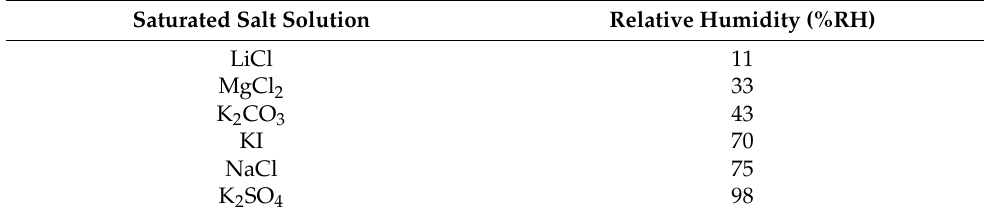
Table 2. The relative humidity of different saturated salt solutions (25 ◦